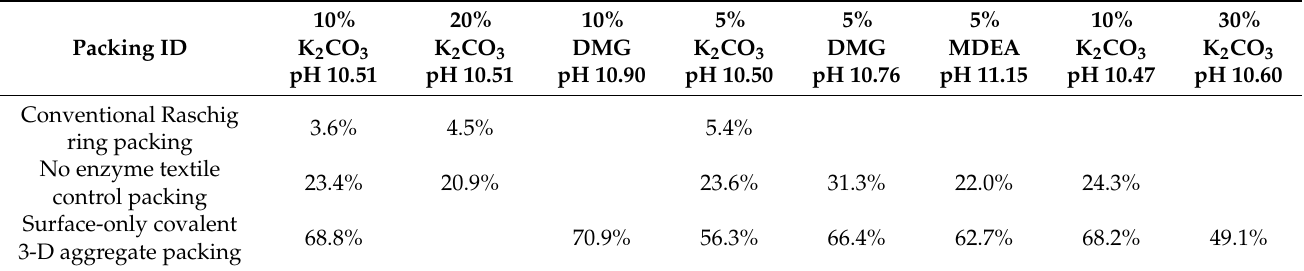
Table 5. CO 2 capture efficiencies of surface-only covalent 3-D aggregate immobilized enzyme packing using various